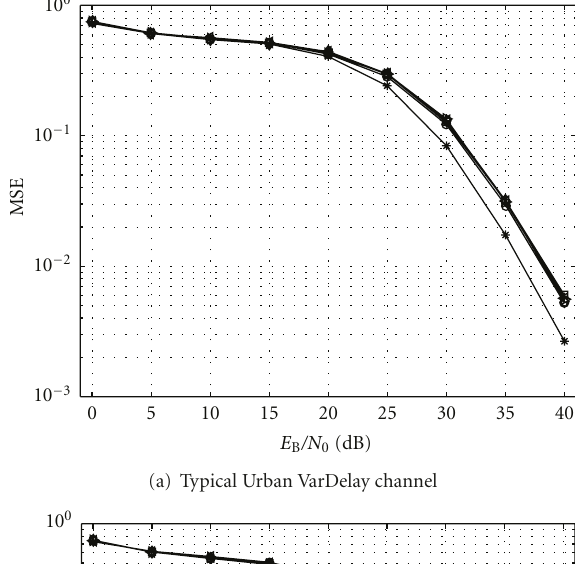
Algorithm 1: Decision-directed channel estimation with iterative wiener filtering.